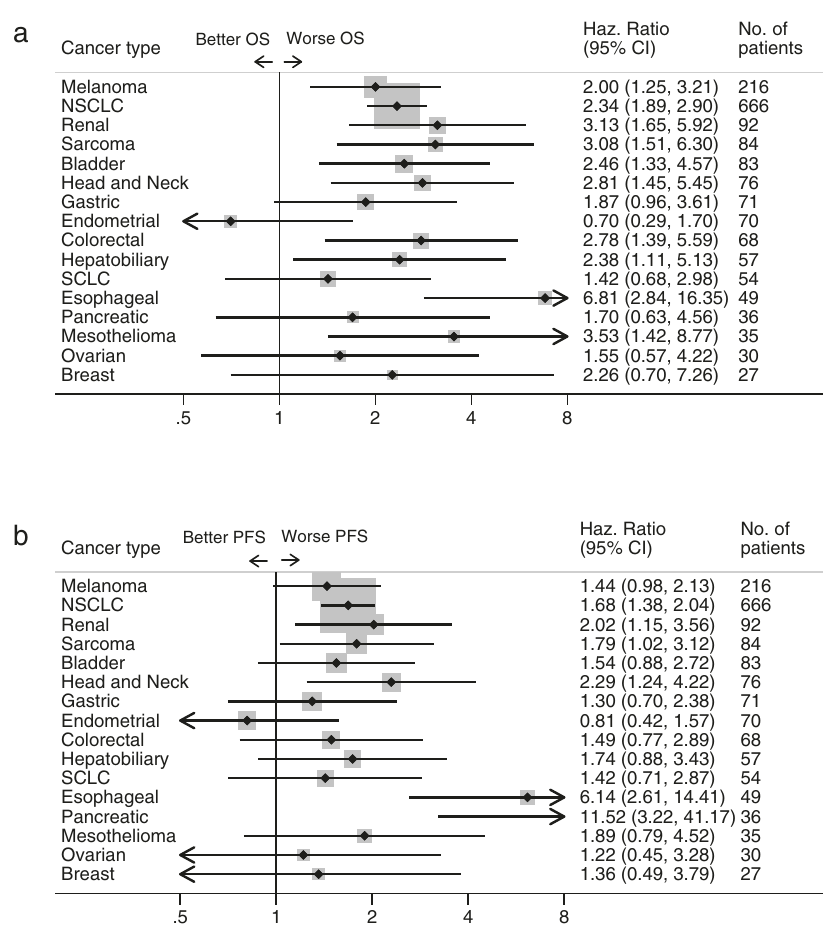
Fig. 2 Outcomes based on neutrophil-to-lymphocyte ratio (NLR) strati fi ed by cancer type. Forest plots showing hazard ratios (HRs) with 95% CIs for a overall survival and b progression-free survival across cancer types, comparing top 20th NLR percentile within each cancer type to bottom 80th. HRs were calculated with Cox proportional hazard regression. Abreviations: OS, overall survival; Haz. Ratio, hazard ratio; CI, con fi dence interval; NSCLC, non-small cell lung cancer; SCLC, small cell lung cancer; PFS, progression-free